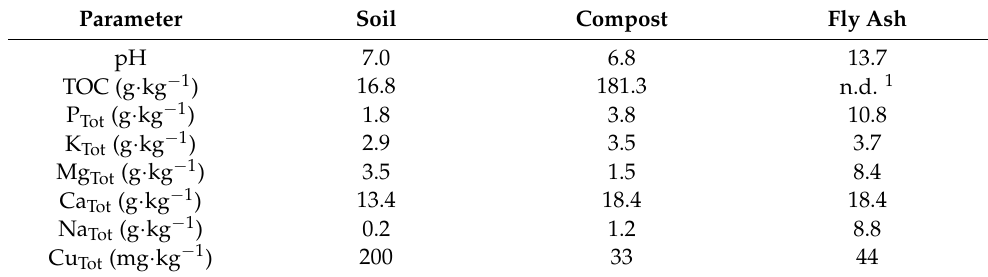
Table 1. Basic properties of soil, compost and fly ash (data for composite samples) (after [19]). Parameter Soil Compost Fly Ash